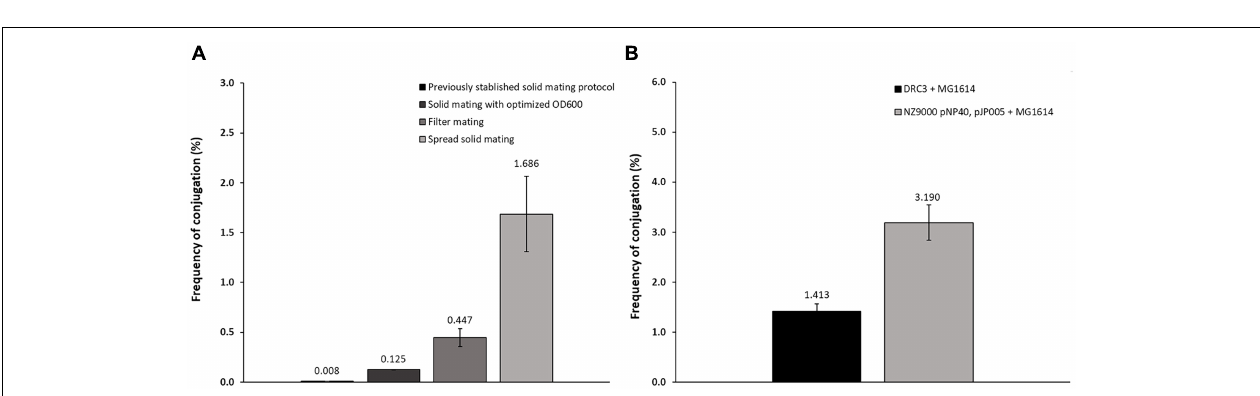
FIGURE 1 | Hierarchal clustering analysis representing the presence/absence of gene families from conjugation clusters of pAF22, pMRC01, and pNP40-like plasmids. Gene clusters are indicated based on the hierarchical tree, top. Color indications refer to the three different conjugative/mobilizable plasmid types identified. Gene names were assigned based on the tra operon of pNP40 (this study) and pMRC01 (publicly available data).